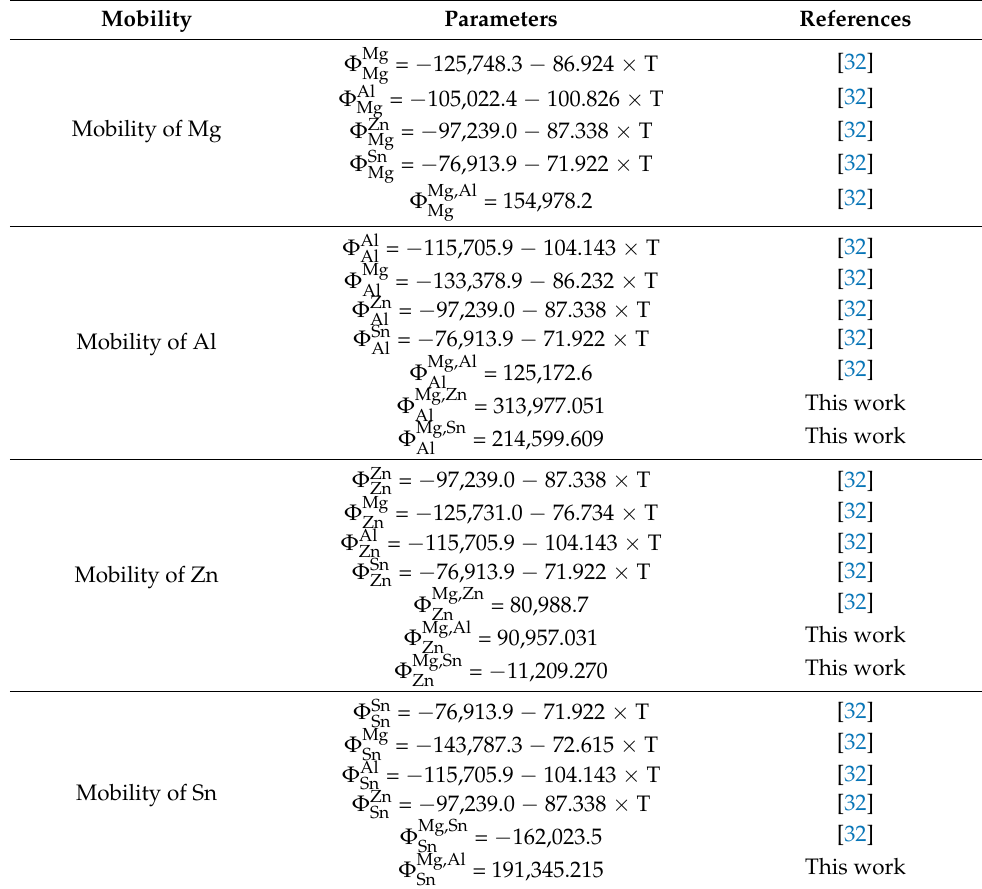
Table 2. List of the atomic mobility parameters of hcp the Mg–Al–Zn–Sn system assessed in the present work together with those taken in the literature